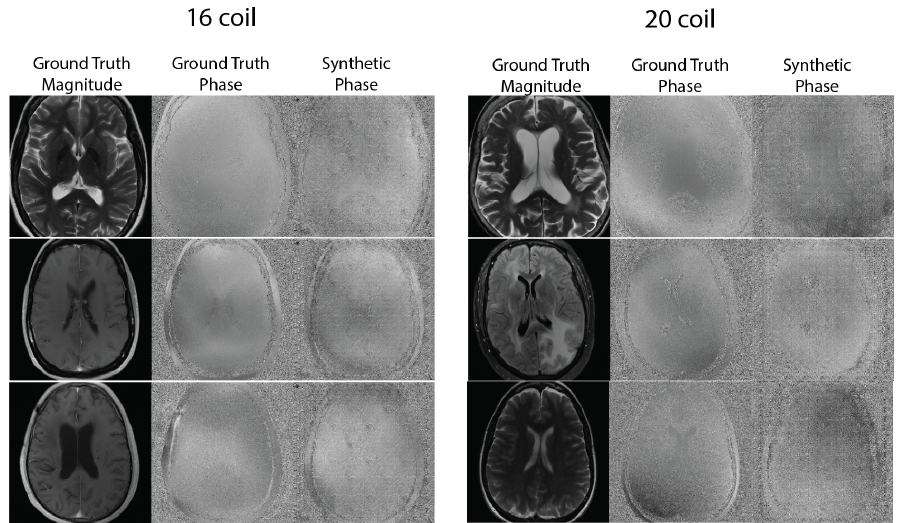
Figure 2. Representative ground truth magnitude, ground truth phase, and synthetic phase im- ages generated from the conditional GAN. Synthetic phase images show expected features, in- cluding appropriate noise patterns, low spatial-frequency components and tissue contrast be- tween the ventricles and nearby brain tissue, but exhibit some blocking artifacts possibly from the patchGAN discriminator.